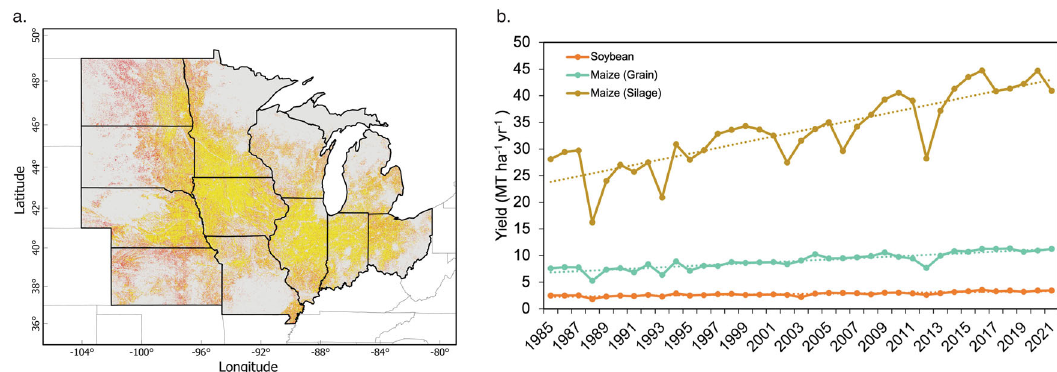
Fig. 2 Midwestern U.S. region maize and soybean. a Map of the study area showing the crop acreage of maize and soybean in 2008 (yellow) and 2020 (red). b Maize and soybean yields from 1985 through 2021 in the study region. The target moisture contents of soybean, maize (grain), and maize (silage) at harvest are ~13%, 15%, and 65 – 70%, respectively. Best fi t lines are slope = 0.03 MT ha − 1 yr − 1 , R 2 = 0.69 (soybean), slope = 0.12 MT ha − 1 yr − 1 , R 2 = 0.75 (maize, grain), and slope = 0.53 MT ha − 1 yr − 1 , R 2 = 0.71 (maize, silage). The linear models are statistically signi fi cant ( p < 0.001). Only the slopes of maize (grain and silage) are statistically different from zero ( p < 0.004). The base map shown in a is from 33 .